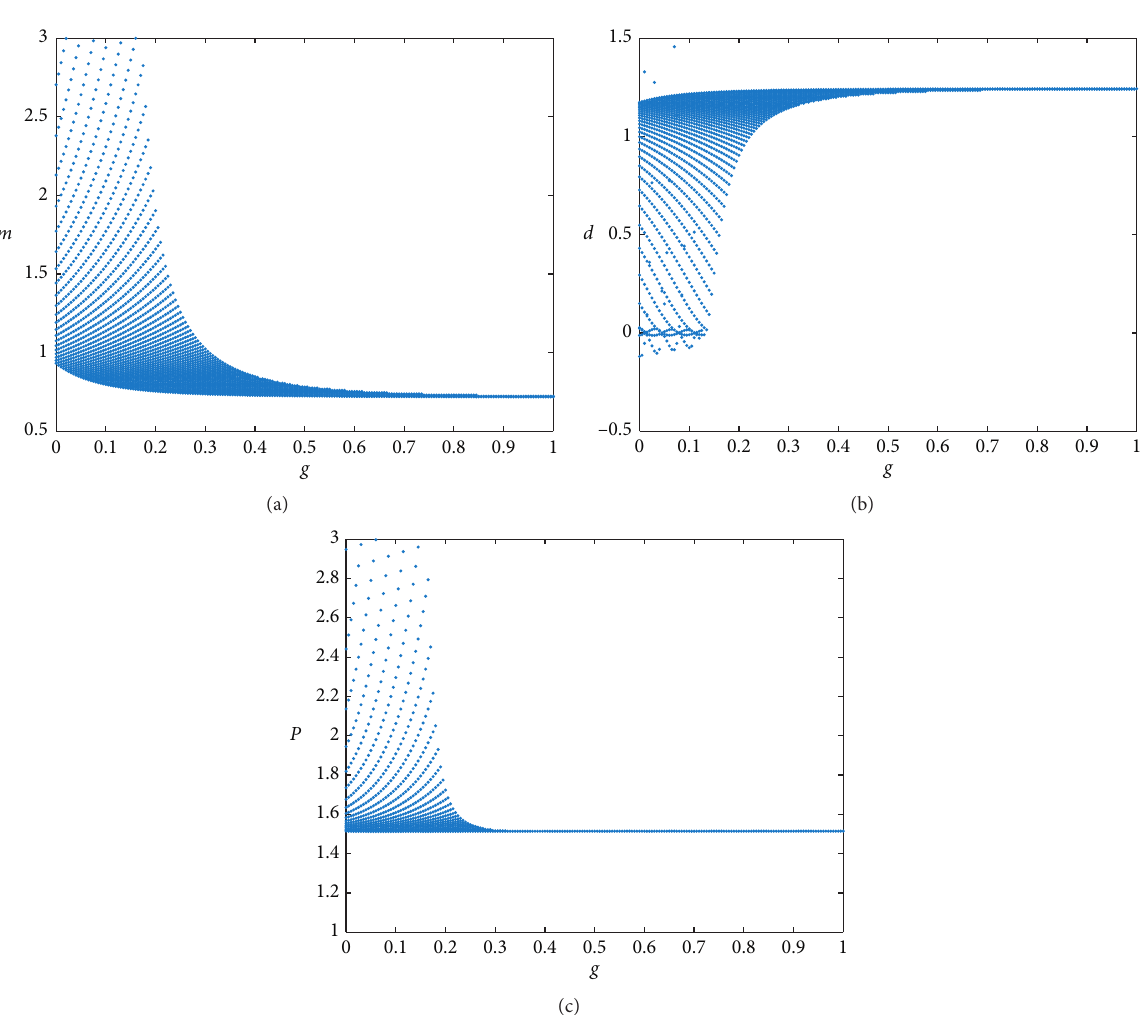
Figure 9: Bifurcation diagram when g increasing. (a) Self-leadership coefficient m . (b) Relational leadership coefficient d , and (c) Leadership effectiveness p